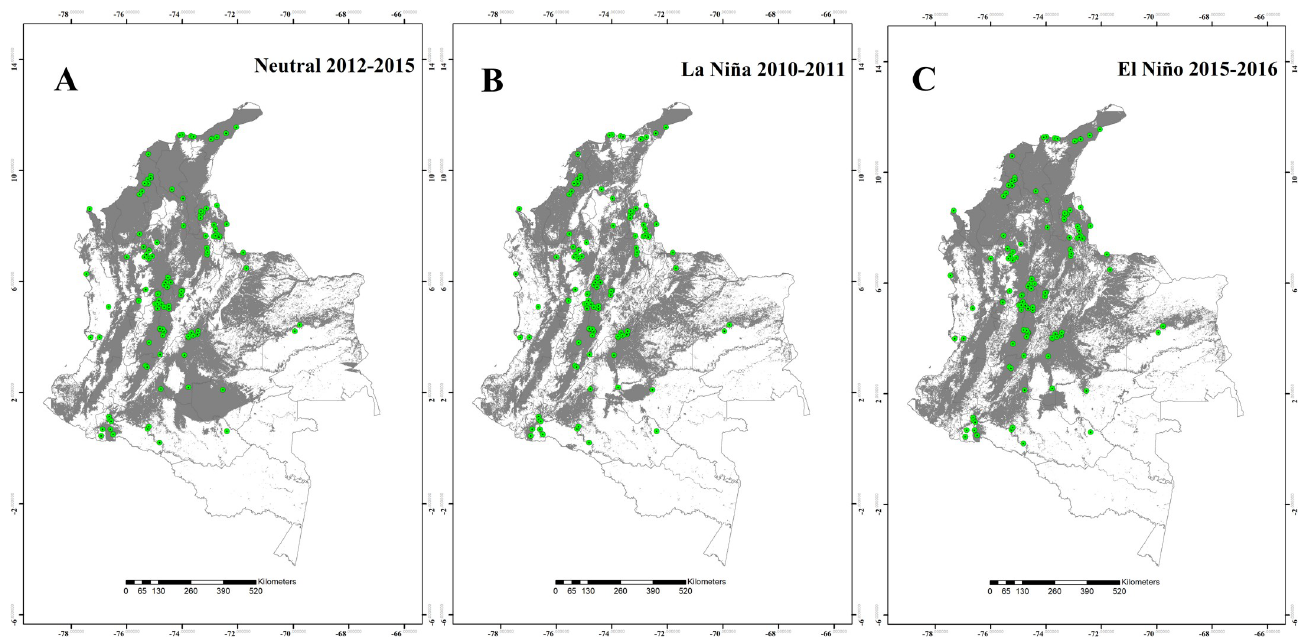
Fig 1. Potential distribution maps for Lutzomyia ovallesi . (A) Neutral 2012–2015 episode. (B) La Ni ñ a 2010–2011 episode. (C) El Ni ñ o 2015–2016 episode. Models were calibrated across the hypothesized area of dispersion (M) and transferred across all Colombia. Green points are occurrences, gray areas are modeled suitable conditions, and white areas are unsuitable conditions. Points correspond to data in S1 Appendix, and maps were done using Maxent and ArcGIS